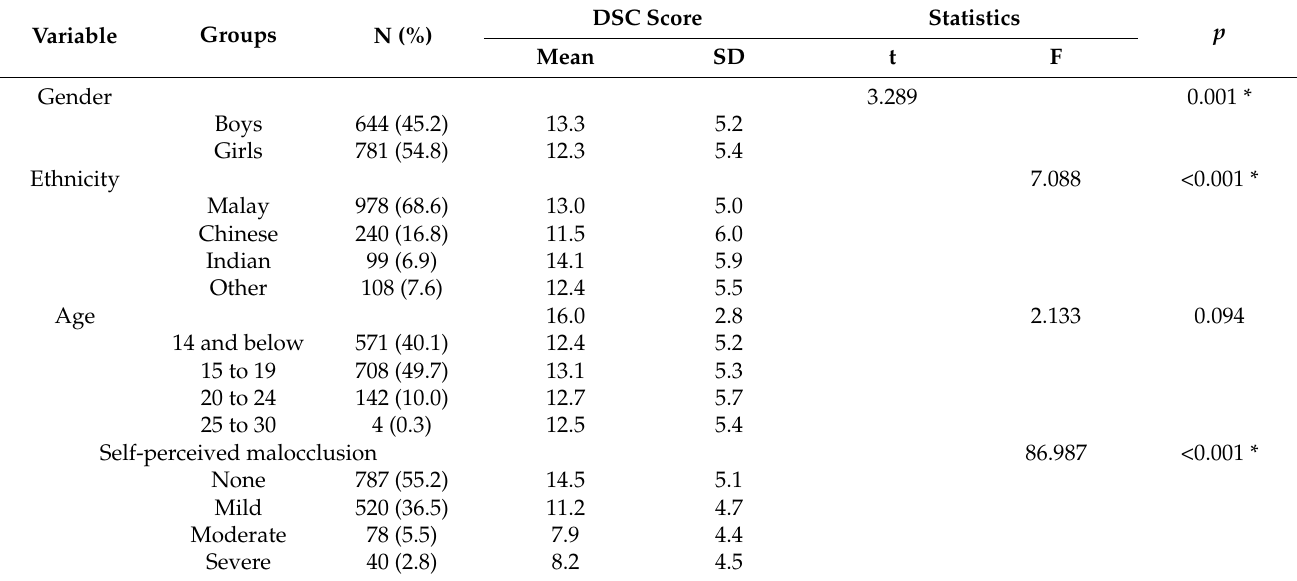
Table 1. Participants’ characteristics and distribution of dental self-confidence (DSC)